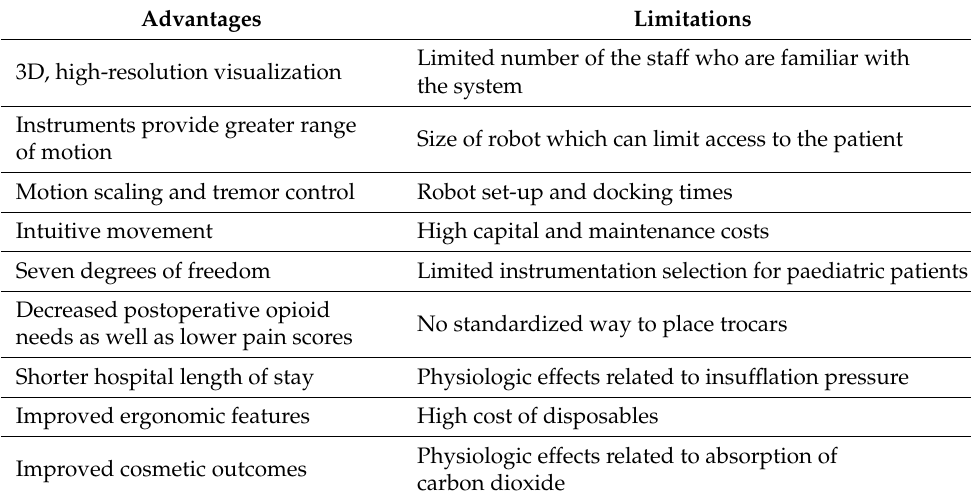
Table 1. Advantages and limitations of robot-assisted